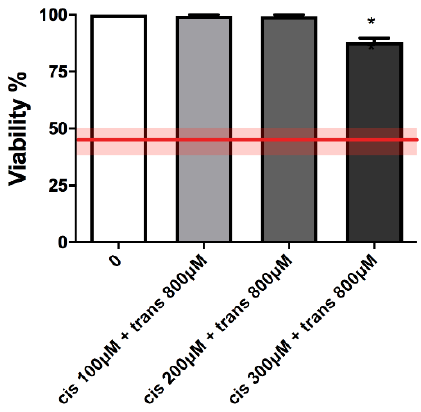
Figure 4. Cell viability of TK6 cells after 26 h co-treatment with (±)cis- 4,4′ -DMAR and (±)trans- 4,4′ - DMAR at the indicated concentrations compared to the concurrent negative control [0 µM]. Each bar represents the mean ± SEM of three independent experiments. Data were analysed using one-way repeated measures ANOVA followed by Bonferroni as post-test. * p < 0.05 vs. [0 µM]. The red line represents the OECD threshold for viability (45 ± 5%). Table 2. RPD of TK6 cells after 26 h co-treatment with (±)cis- 4,4′ -DMAR and (±)trans- 4,4′ -DMAR at the indicated concentrations compared to the concurrent negative control [0 µM]. Each value represents the mean ± SEM of three independent experiments. Data were analysed using one-way repeated measures ANOVA followed by Bonferroni as post-test. * p < 0.05 vs. [0 µM]. Concentration RPD 0 µM